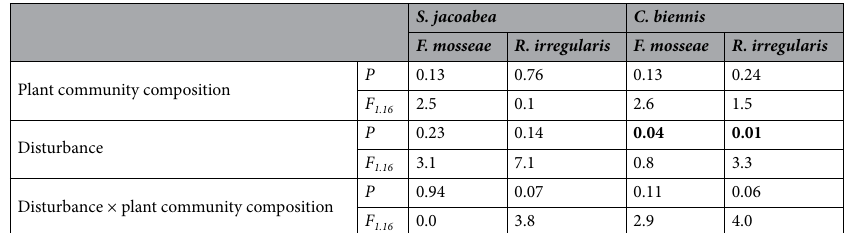
Table 3. Significance of effects of plant community composition (monocrop or multicrop) and disturbance, and their interaction on the abundance of different arbuscular mycorrhizal fungal taxa in root samples of the perennial plant species Senecio jacobaea and Crepis biennis . F ‐ values (F) and levels of statistical significance ( p -value ranges, P ) as per two-way ANOVAs are shown (n = 5). Significant results are stated in bold.